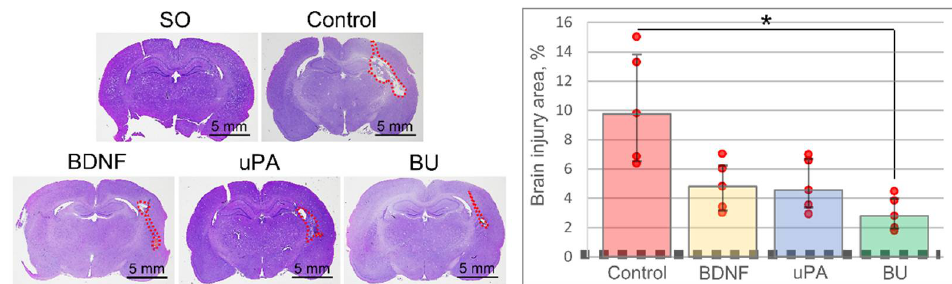
Figure 3. The histological examination of brain slices. Hematoxylin-eosin staining reveals the site of damage (red dashed curved line). On the diagram: the dashed line corresponds to the area of the brain lesion in sham-operated (SO) animals and the red dots—to the result of individual measurements. The data are presented as the median (25%; 75%). *—H (3, 12) = 11.046, p = 0.011. BDNF, brain-derived neurotrophic factor; BU, BDNF + uPA; uPA, urokinase-type plasminogen activator.